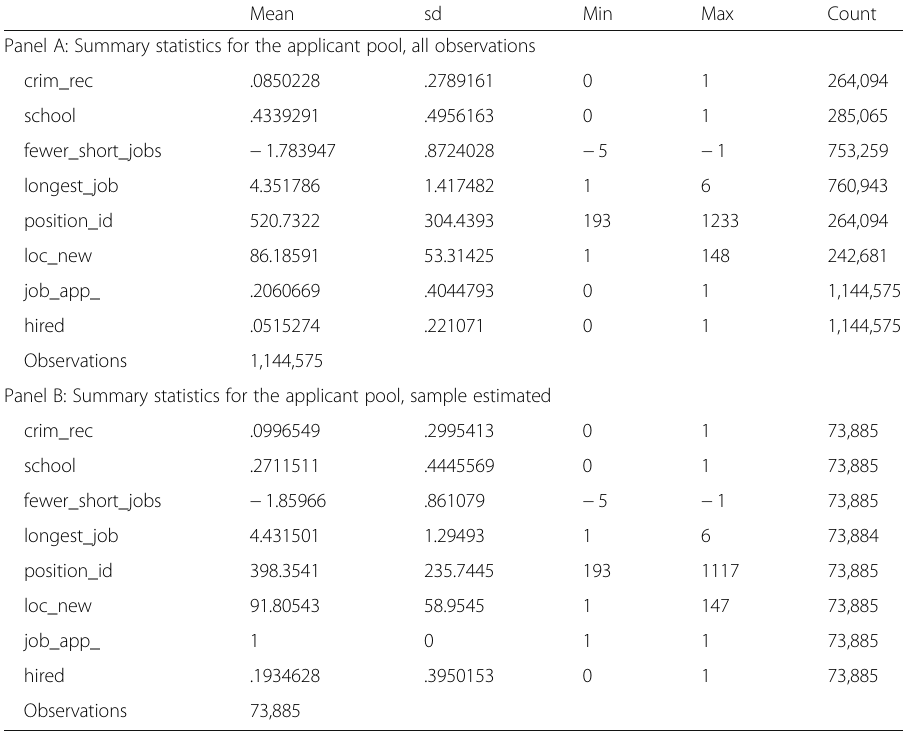
Table 1 Summary statistics for the applicant